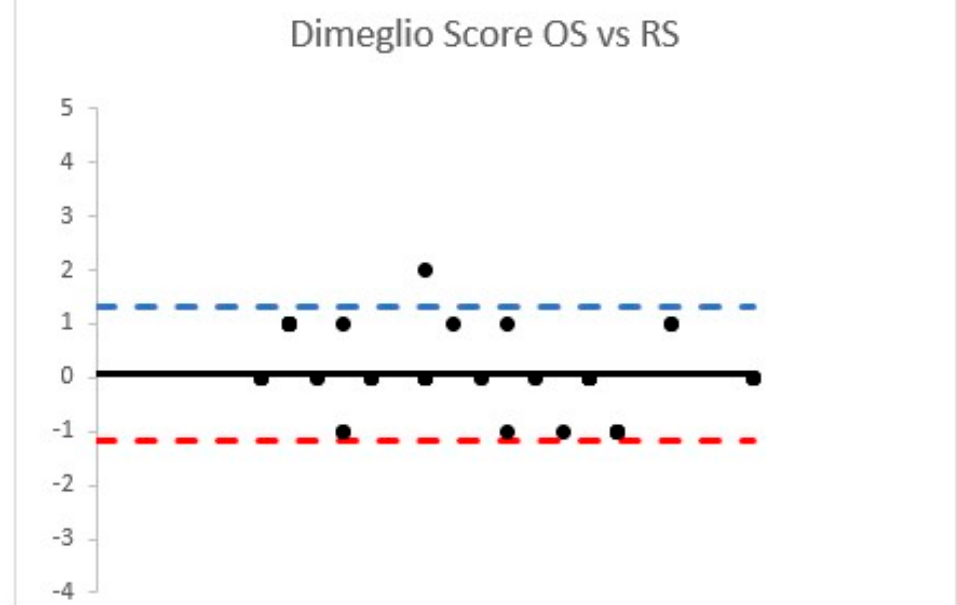
Figure 2. Bland Altman plots according to OS and RS Dimeglio score.